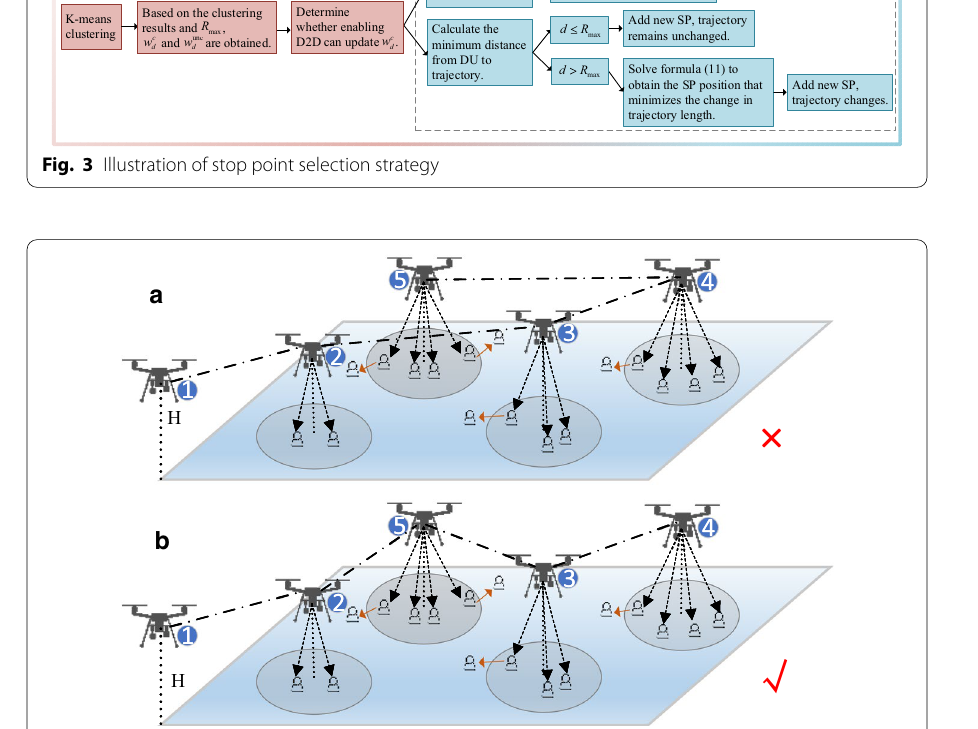
Fig. 4 Schematic diagram of stop points